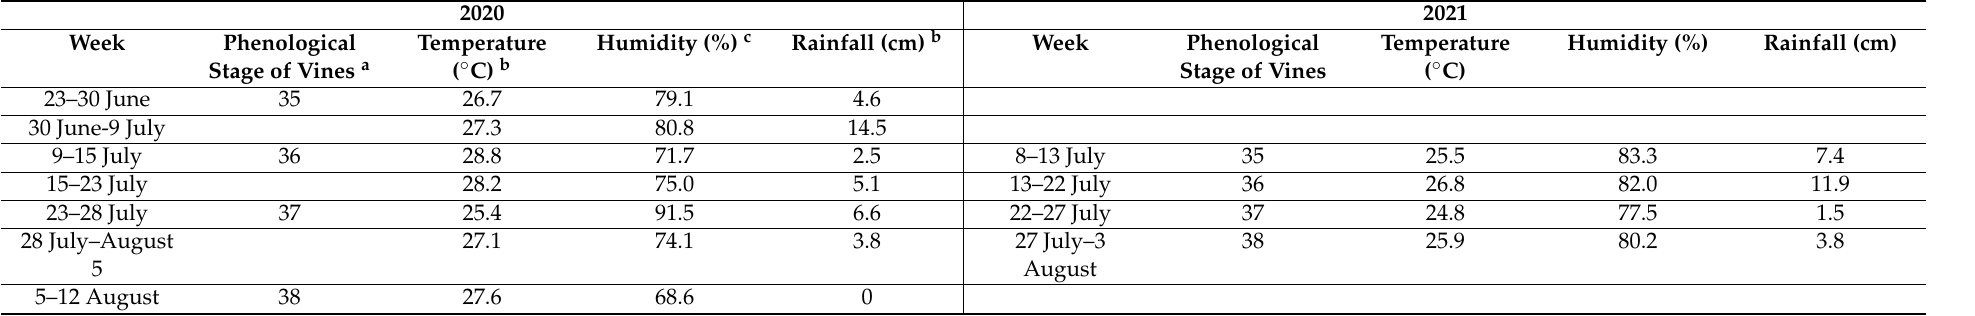
Table 3. Weekly phenological stage, rainfall, and average temperature and humidity in McNeill, MS starting from ‘MidSouth’ veraison to harvest for vines